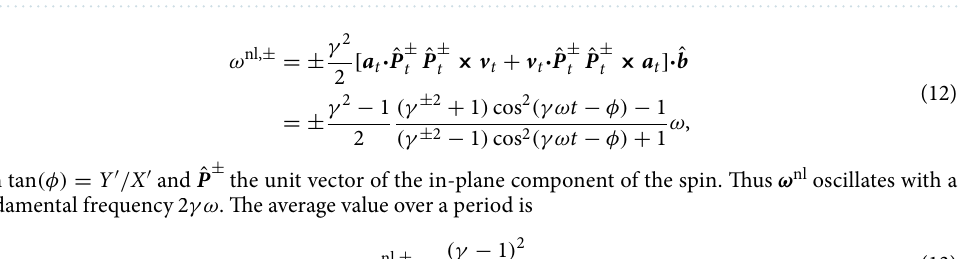
Figure 3. The variation in time of the total spin squared S 2 and T 2 divided by (cid:31) 2 . For the sake of comparison, 1 / √ 2, Y 0, Z 1 , as in 14 (pp. 175–176). We put v we considered the values X ′ ′ = ′ = = of Lorentz dilation/contraction evident. As discussed in the text, in an atom the speed of the orbiting electrons is too small compared to c to allow to detect the